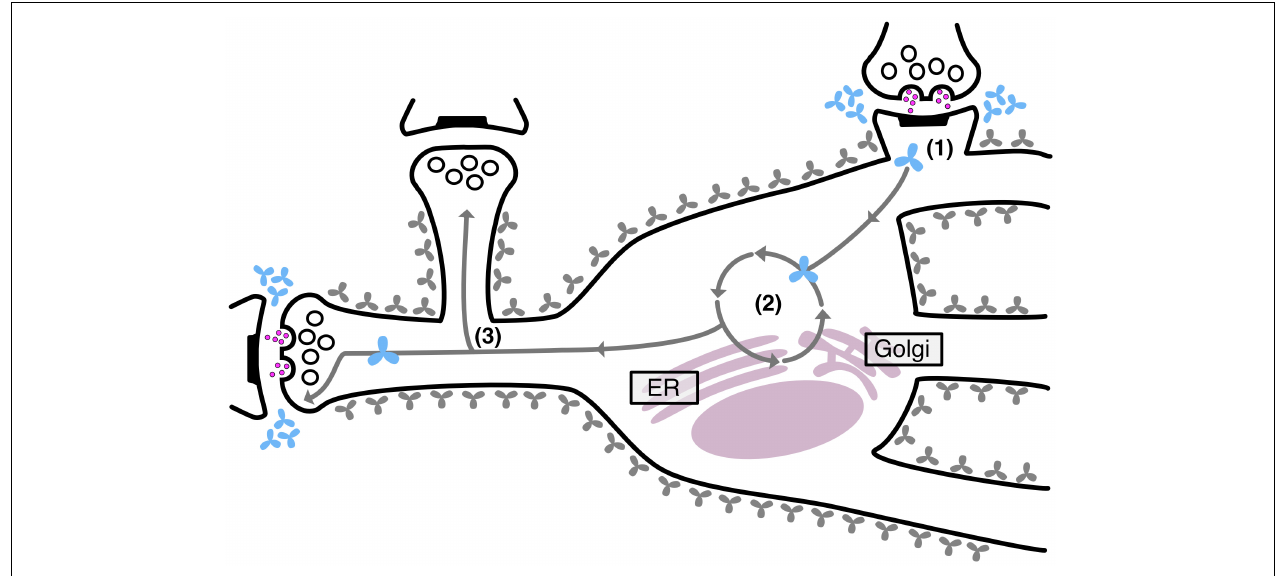
FIGURE 4 | TNR recycling mechanism and function in neurons. Neurons contain two pools of TNR molecules: a stable pool (gray molecules) and a recycling pool, which is enriched at synapses (blue molecules). After their internalization at synapses (1), the recycling TNR molecules are trafficked to the Golgi apparatus and the endoplasmic reticulum, where they appear to undergo a re-glycosylation (2). At the end of their route, these molecules are once again trafficked to synapses (3). Stronger synapses (with a larger pool of actively recycling presynaptic vesicles or with larger postsynaptic spine heads) have more recycling TNR molecules in their